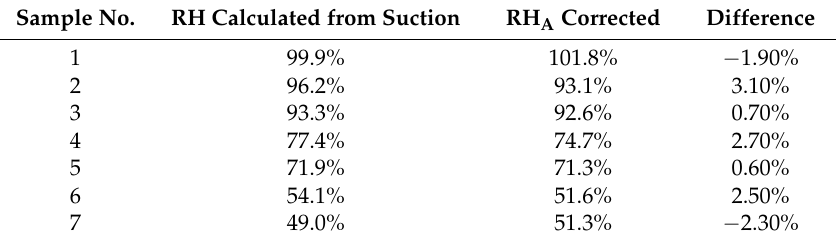
Sample Table 2. Corrected RH of hydrated bentonite samples measured by the psychrometer and by the sensor.